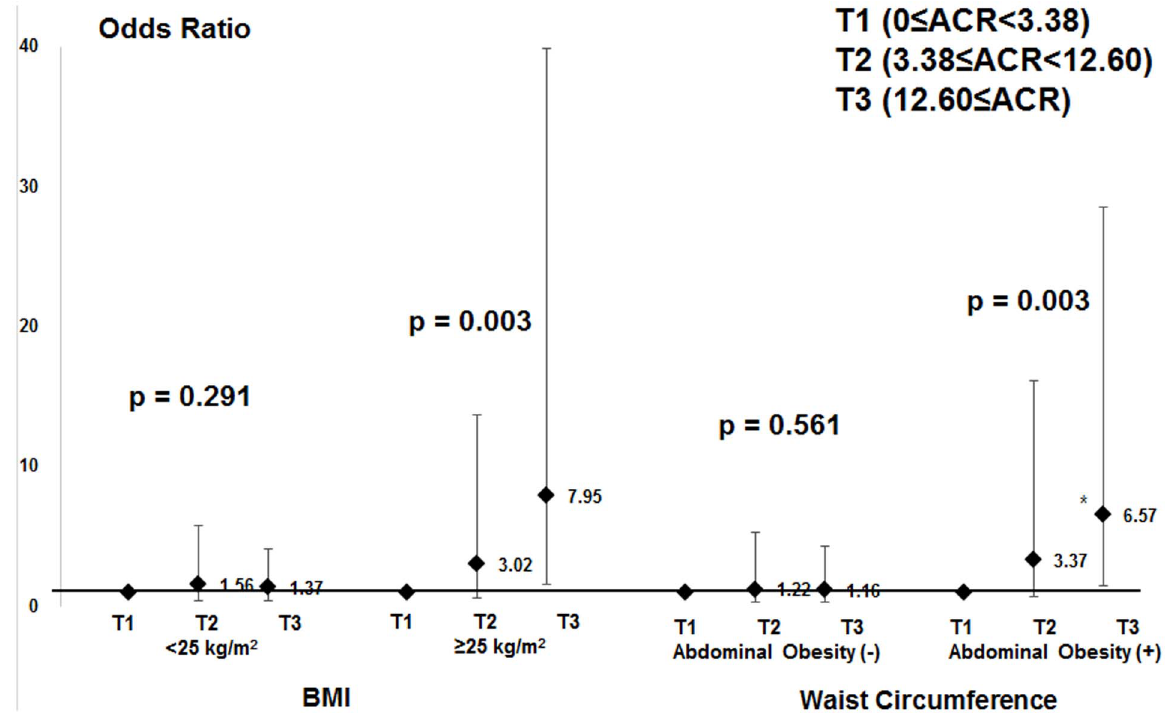
Figure 3. Adjusted odds ratio for high intraocular pressure (IOP; $ 18 mmHg) according to albumin/creatinine ratio (ACR) tertiles in subgroups based on body mass index and waist circumference. The error bars represent 95% confidence intervals. Odds ratios were estimated using a multiple logistic regression analysis after adjusting for age, gender, hypertension BMI, triglycerides, region of habitation, and education level. The P values for trends are shown.